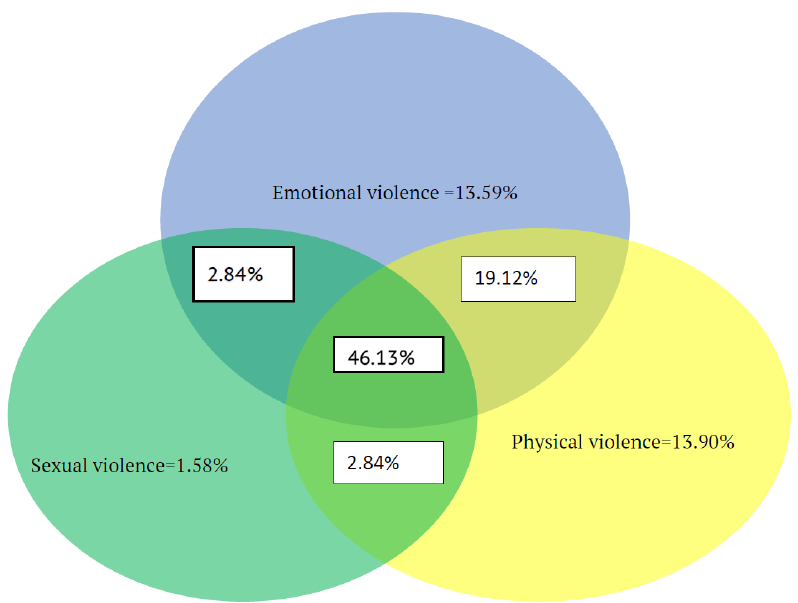
Figure 1. Venn diagram showing the overlap of types of gender-based violence (GBV) committed by male high school students during their lifetime in East Hararghe, eastern Ethiopia, December 2018. The size of the circles is not proportional to the percentage of each type of GBV.